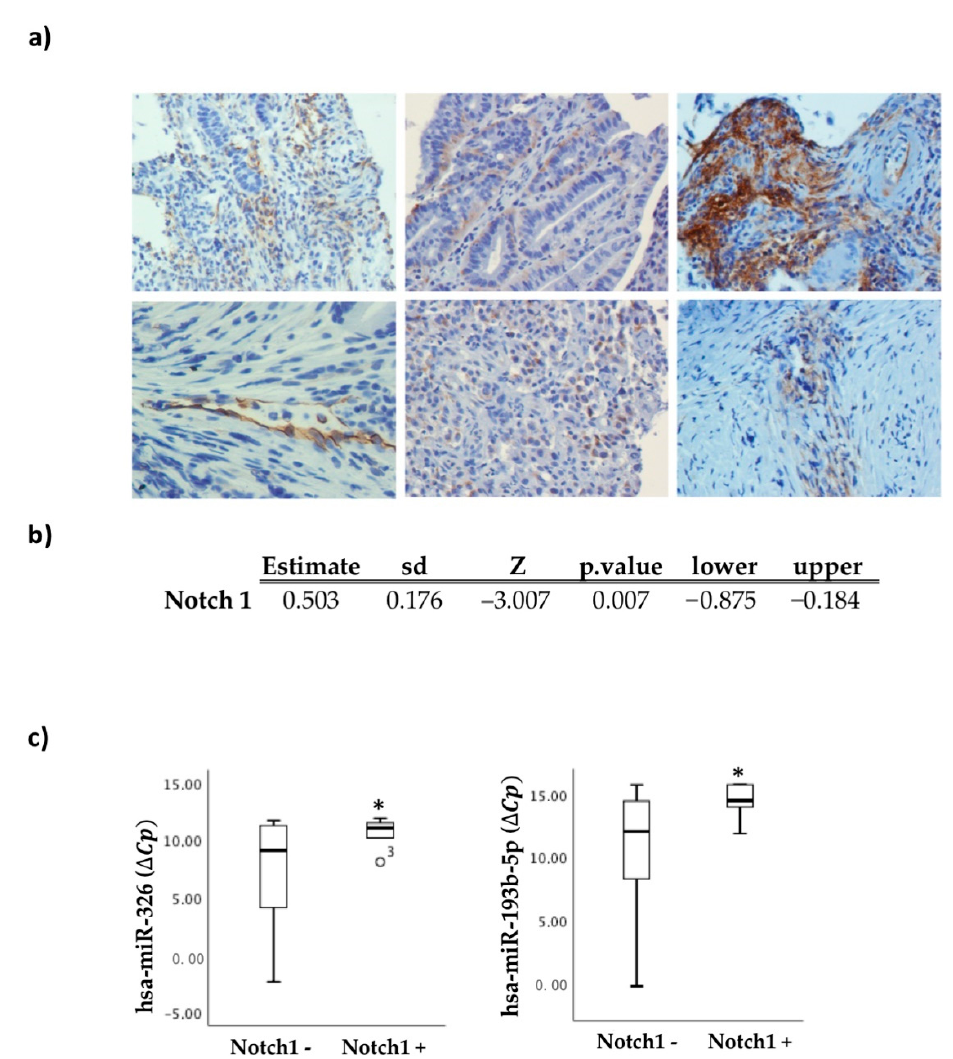
Figure 8. Notch 1 determined in primary tumors as a predictor of response to regorafenib. Notch 1 expression in primary tumor biopsies correlates with the response to regorafenib. ( a ) Representative images of Notch expression studied by immunohistochemistry in paraffin-embedded sections. Image magnification: 300 × . ( b ) Logistic regression model of clinical variables and Notch expression with the response to regorafenib treatment. ( c ) Statistical association of selected tissue miRNAs with Notch 1 expression. miR-326 and miR193-5p expression in primary tumors also correlates with the presence or absence of Notch 1 in the biopsies (Notch 1 − n = 18; Notch 1 + n = 11). miRNA levels are expressed as the delta-crossing threshold (DCT); the mean of miR-103a-3p Cq and miR-30c-5p Cq was used as a normalizer Cq. Only miRNAs showing a statistically significant association between the two represented categories are shown. Data are presented as the median and interquartile range, with * p < 0.05, ° outliers values.